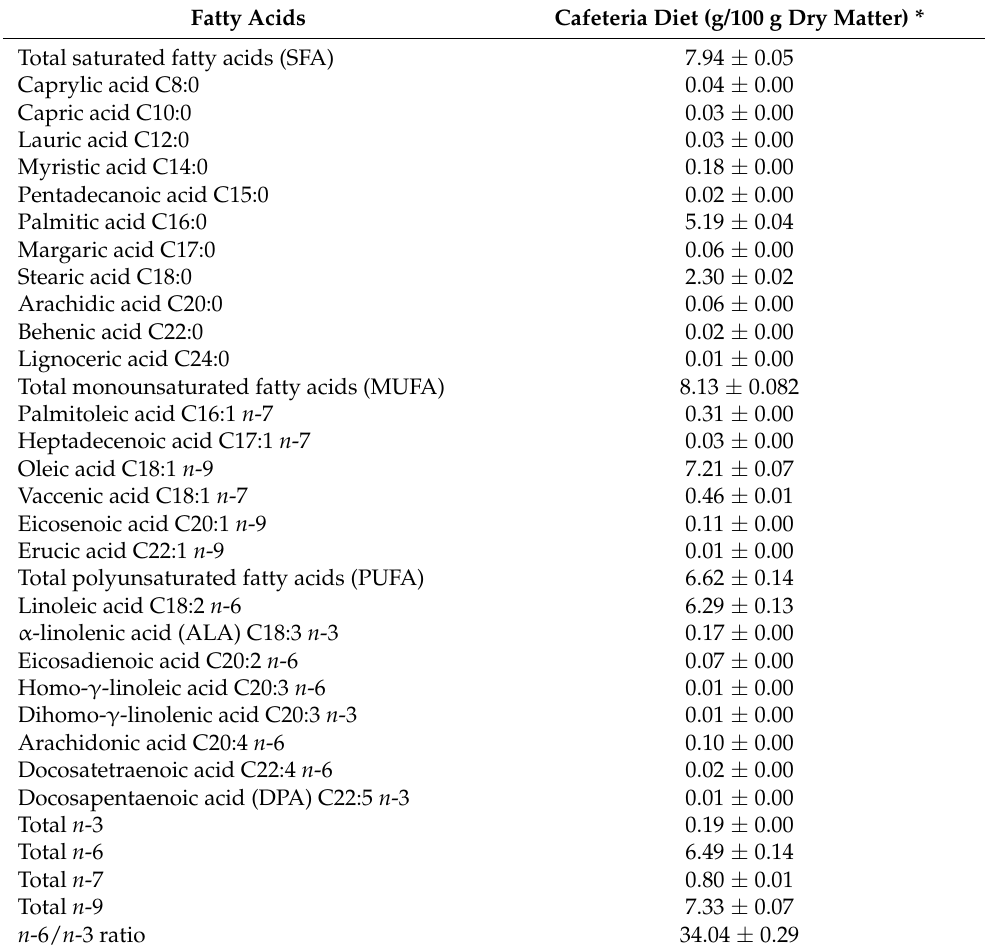
Table 1. Fatty acid content (g/100 g dry matter) in the artisanal cafeteria diet. Fatty